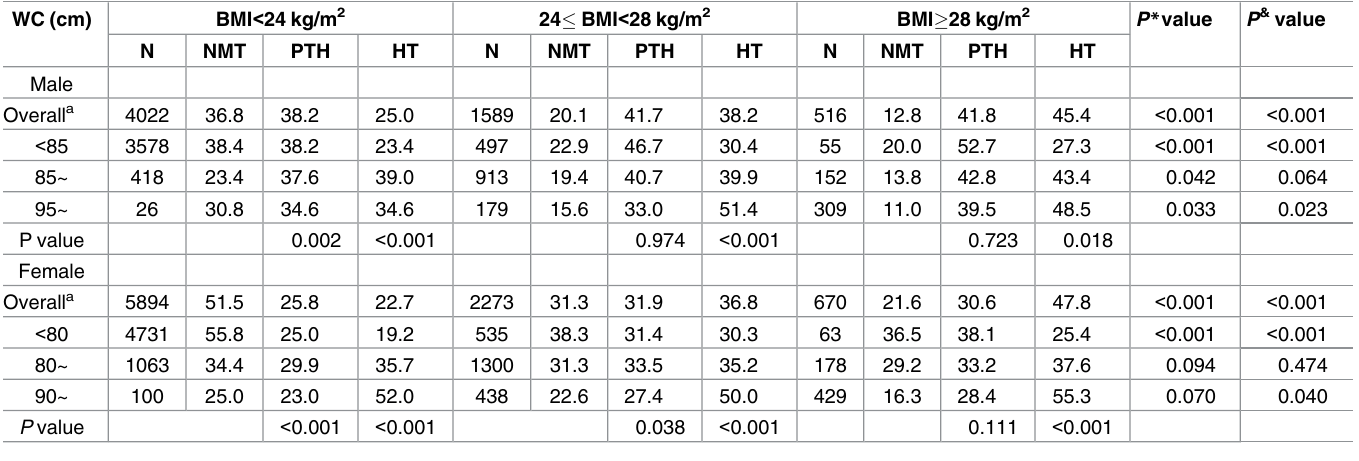
in VAI ( χ 2 = 355.29, P < 0.001; χ 2 = 121.23, P < 0.001) (Fig 2A). When VAI was (cid:21) 10, the prev- alence of hypertension was higher than that of prehypertension. Also, the prevalence of hyper- tension and prehypertension increased with an increase in BFP ( χ 2 = 1416.40, P < 0.001; χ 2 = 528.38, P < 0.001)(Fig 2B). Moreover, the gap between the prevalence of hypertension and prehypertension gradually shortened. When BFP was (cid:21) 25% for males and (cid:21) 35% for females, the prevalence of hypertension was higher than that of prehypertension. Table 3. Prevalence of prehypertension and hypertension stratified by BMI and